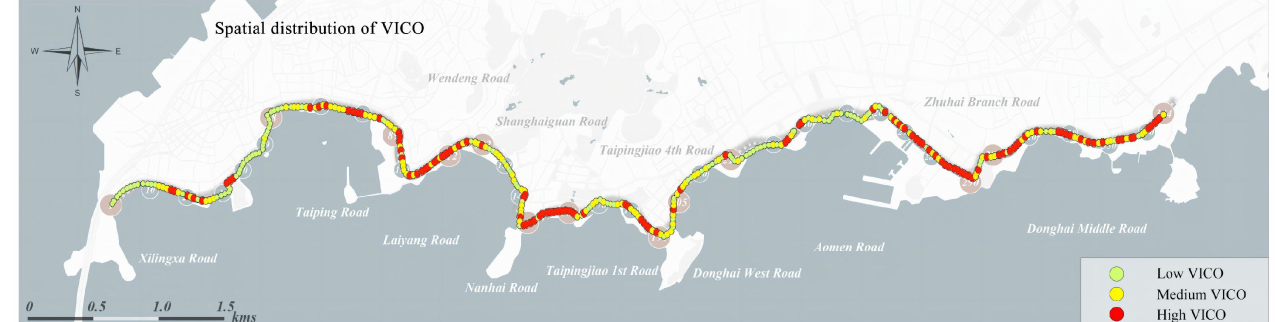
Figure 10. Spatial distribution of